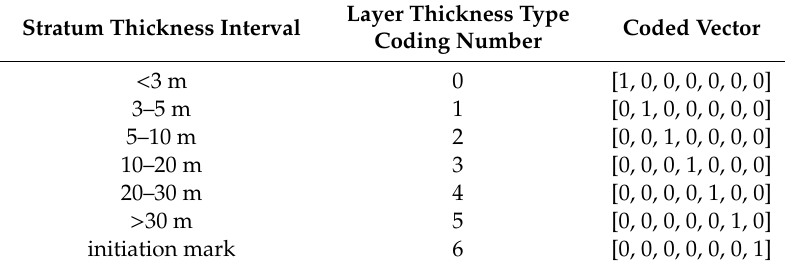
Table 6. Code of the layer thickness